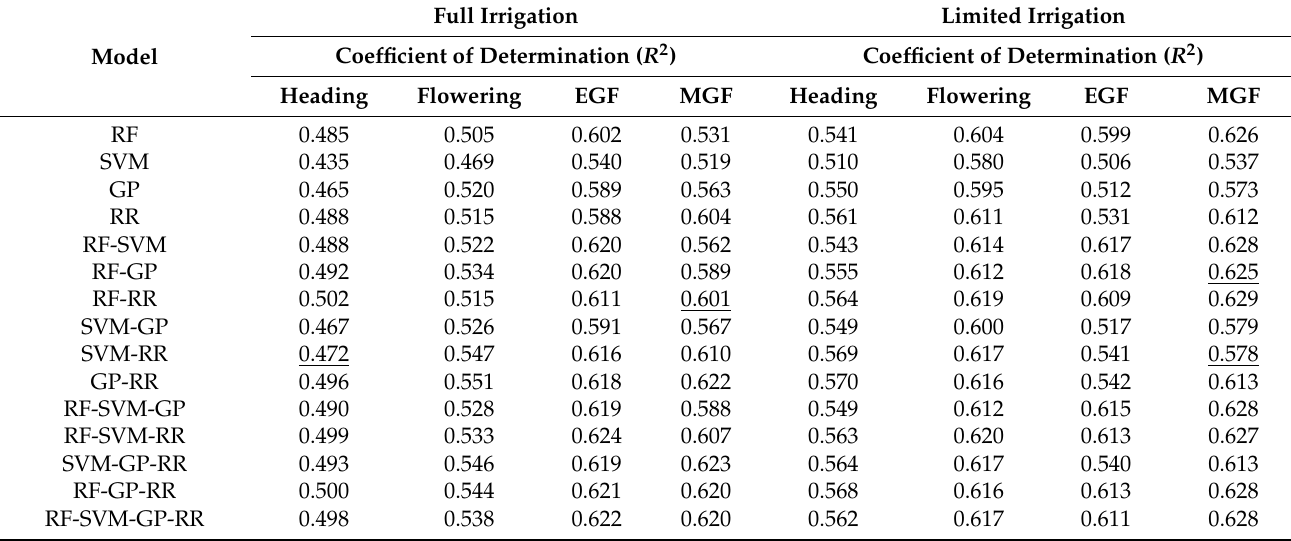
Table 5. Test accuracies ( R 2 ) of base models and ensemble models for grain yield prediction.